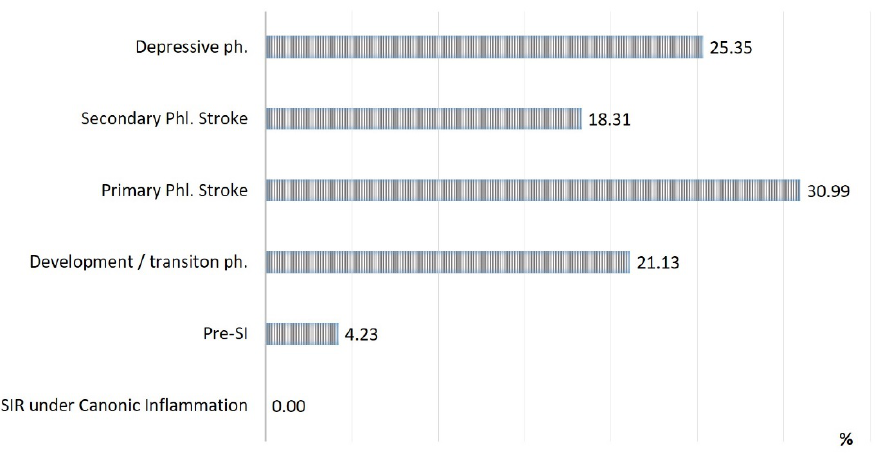
Figure 3. Lethality in each phase of SI (n = 71).